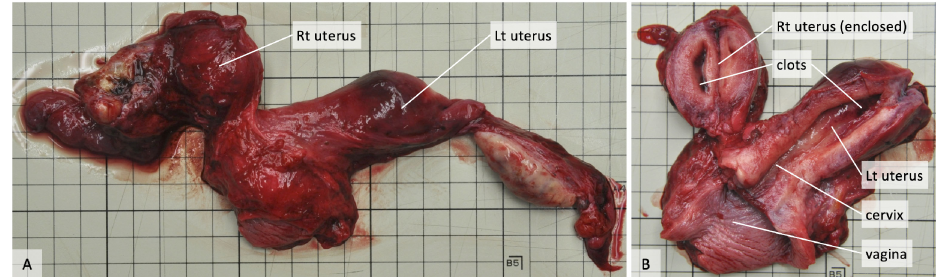
Fig. 1 Macroscopic images of the uterus, ovaries and salpinx. Macroscopic fi ndings of the bicorporeal uterus, normal ovaries, and normal salpinx (A). The left side of the uterus communicated with the normal cervix and normal vagina, while the right side of the uterus was enclosed (B).